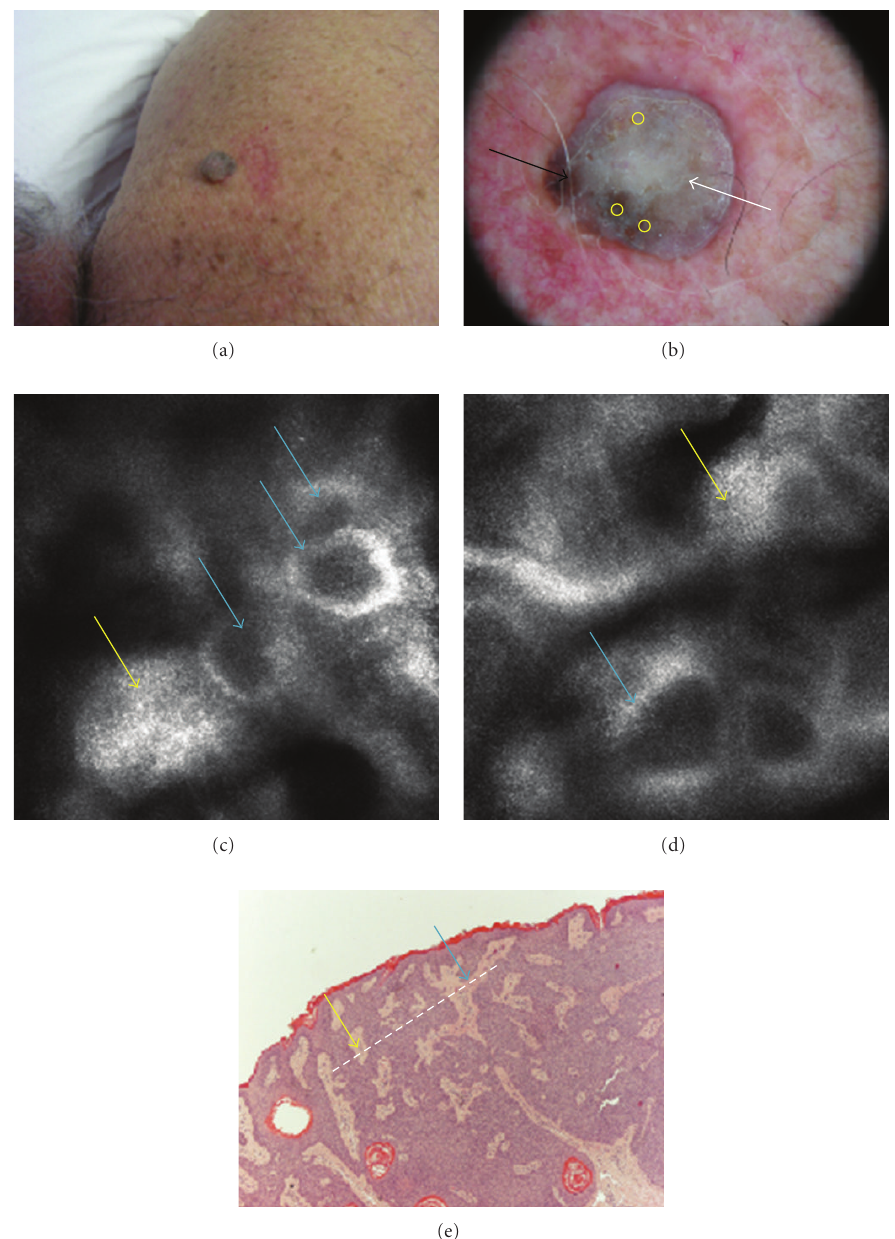
Figure 2: Back of a 58-year-old man. This grayish nodule of unknown history was warty and itchy (a). Dermoscopy showed a whitish veil all over the lesion (white arrow), comedo-like openings (yellow circles) and a hyperpigmented area at the periphery (black arrow) ((b) 20x mag- nification). The confocal examination shows the lack of the melanocytic component, bright papillary structures (blue arrows) with bulbous projections of epidermal cells, characterized by a blurred appearance (yellow arrows), due to superficial hyperkeratosis ((c), (d) details 500 × 500 µ m). Histology shows a seborrheic keratosis ((e) HH 10x magnification); along the horizontal section (white interrupted line), epithelial cell proliferation corresponds to bulbous projections (yellow arrow) circumscribing dermal areas corresponding to papillae (blue